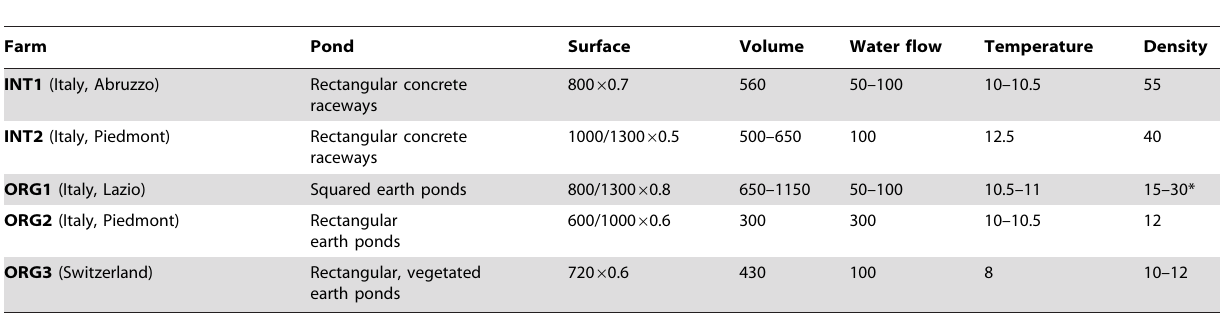
Table 1. Features of the farms where fish were collected (organic ones in grey).